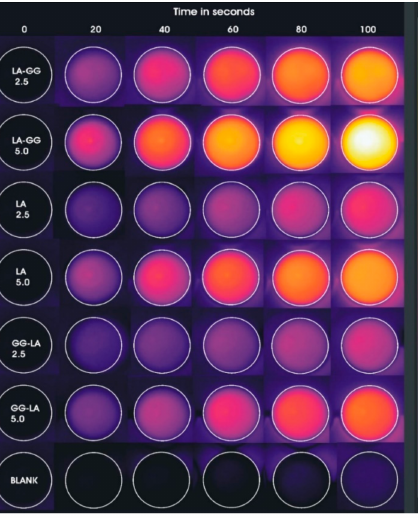
Figure 6. Images acquired by thermal imaging camera during laser hyperthermia studies in 24-well plates (laser power of 10 × 10 − 3 W / mm 3 ) of AuNRs / LA,GG, AuNRs / LA, and AuNRs / GG-LA samples corresponding to gold concentrations of 2.5 and 5 µ g · mL − 1